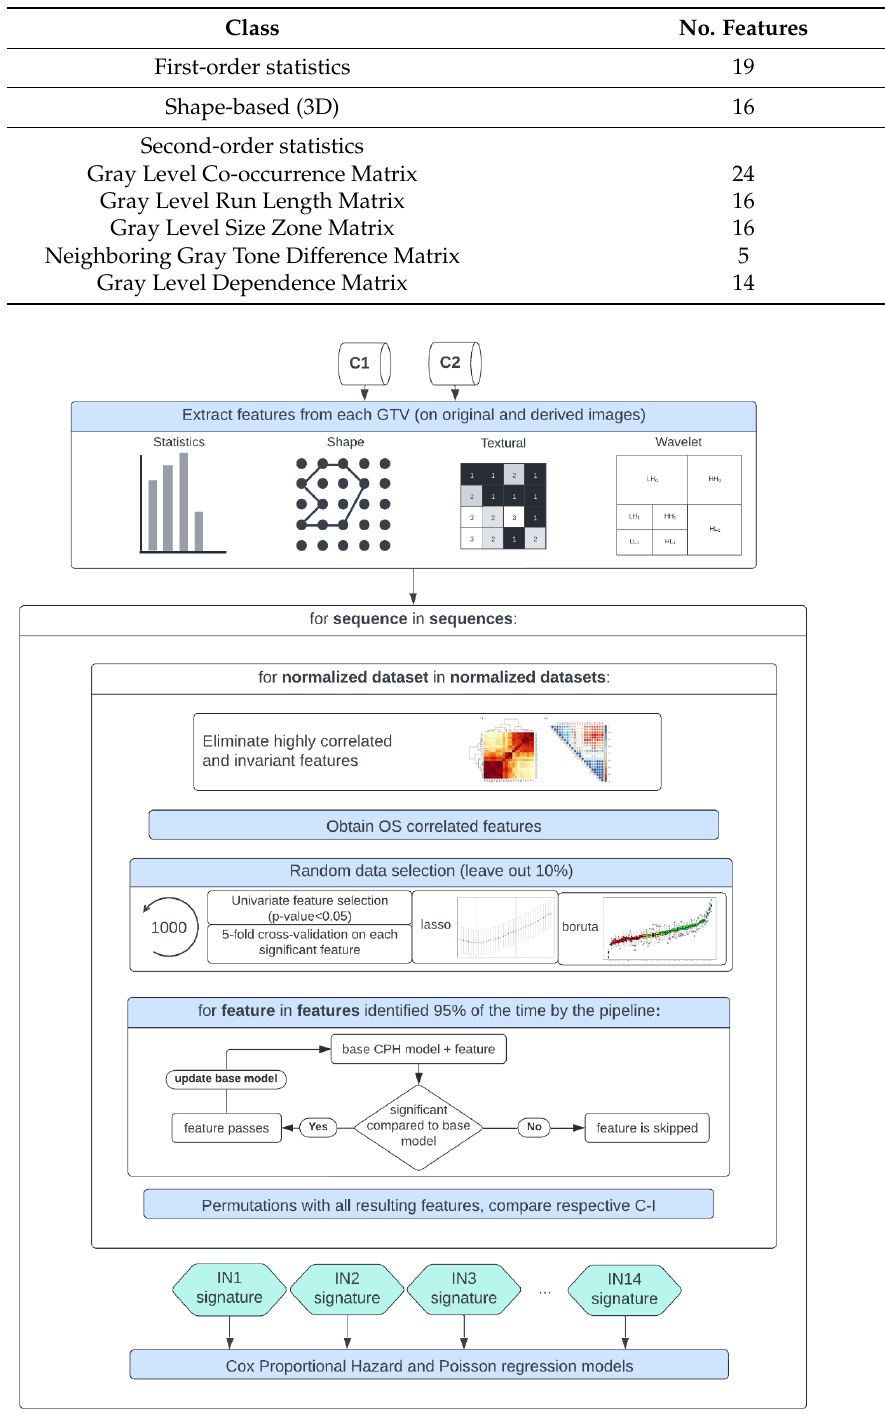
Figure 2. Study workflow—following MR image preprocessing on cohorts C1 and C2, features were extracted from each normalized dataset, intensity normalization method-specific radiomics signatures were derived, and Cox proportional hazards and Poisson regression models were trained.